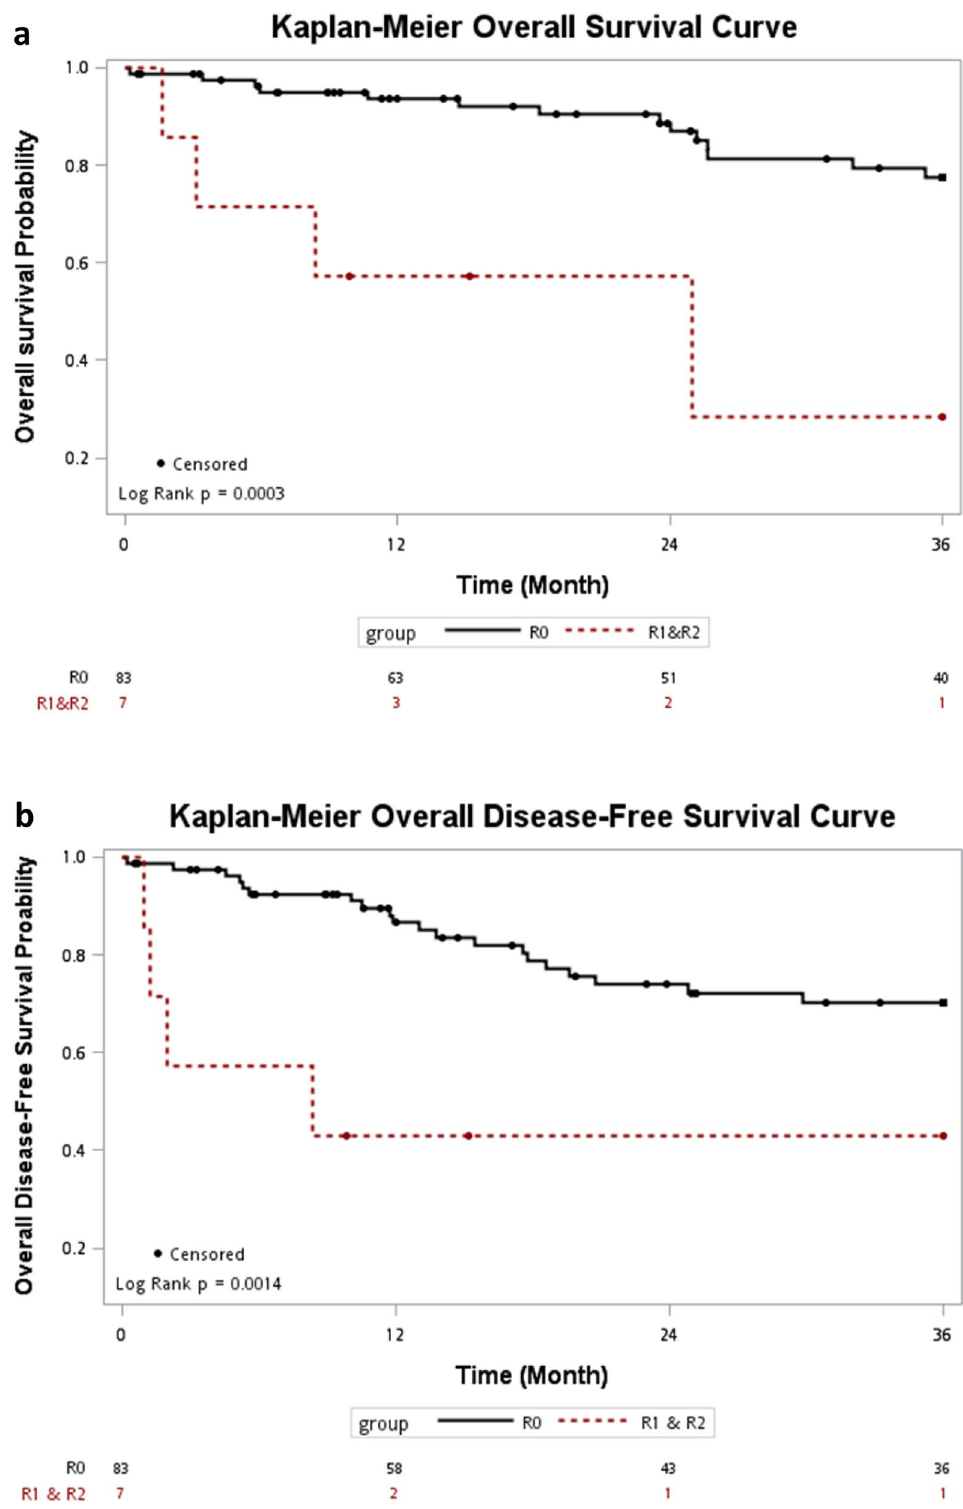
Figure 3. ( a ) Overall survival according to the radicality. ( b ) Disease-free survival according to the